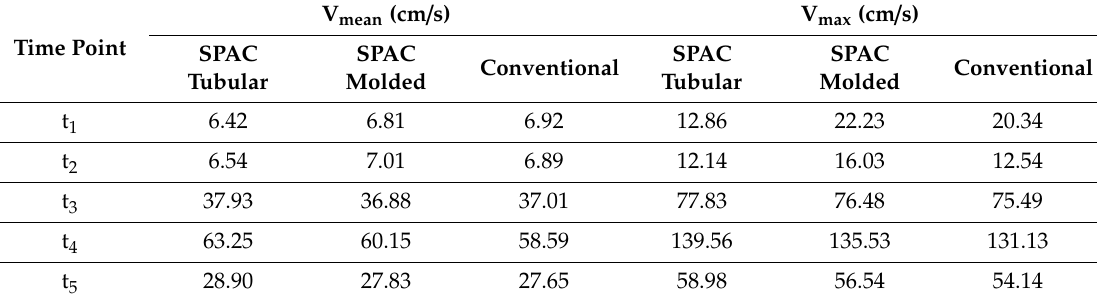
Table 2. The averaged jet velocity (V mean ) and maximum jet velocity (V max ) of all cases in the systolic phase.